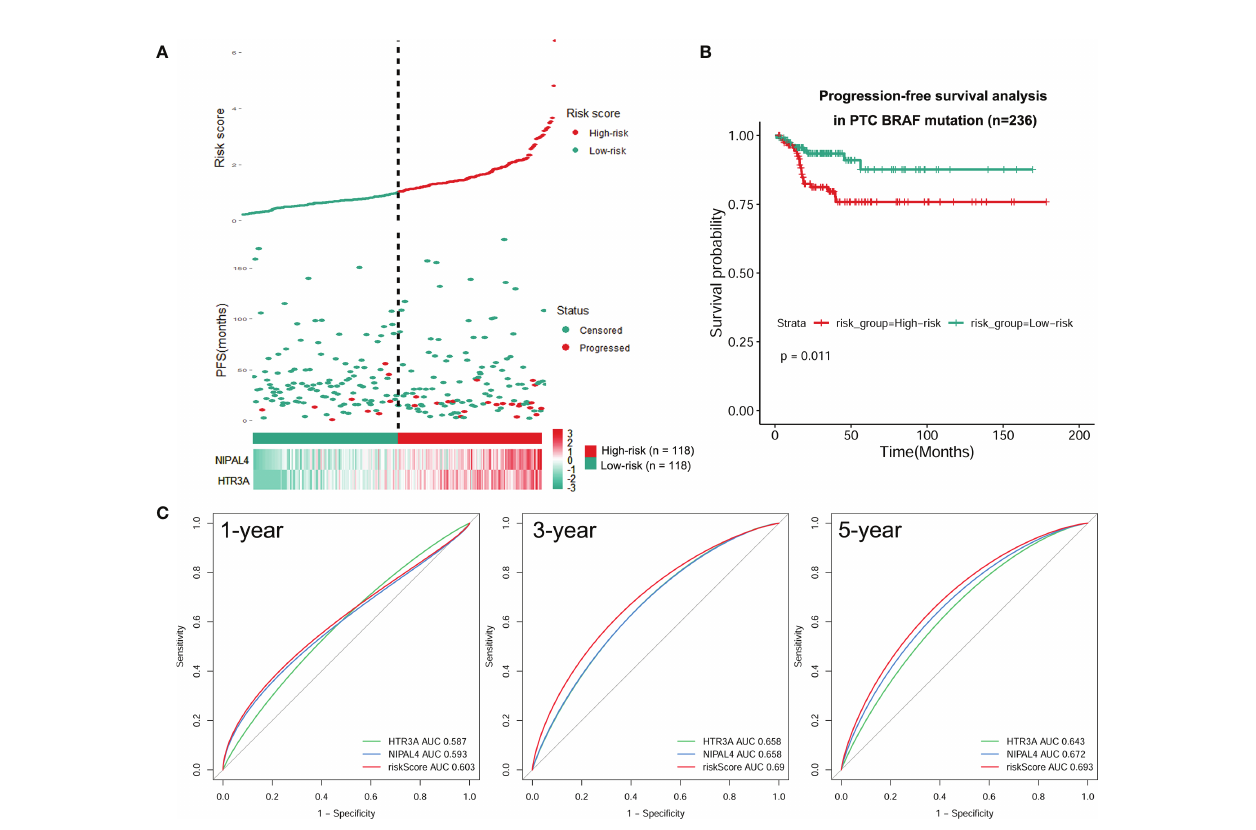
FIGURE 7 | Construction of a risk model for BRAF-mutated PTC. (A) Risk score based on survival status, 2 DEG signatures and expression heatmap for each patient with BRAF-mutated PTC. Elevated expression levels of HTR3A/NIPAL4 and the disease progression rate in patients with BRAF-mutated PTC were positively correlated with high risk scores. (B) PFS difference between high- and low-risk groups using the Kaplan – Meier curve. The Kaplan – Meier survival curves revealed that the high-risk group had a lower PFS rate than the low-risk group ( p < 0.05). (C) The tROC curve of the prognostic risk model compared to the single-variable models. The tROC curve at 1, 3 and 5 years revealed that the AUC for the risk score was higher than that for any single gene.